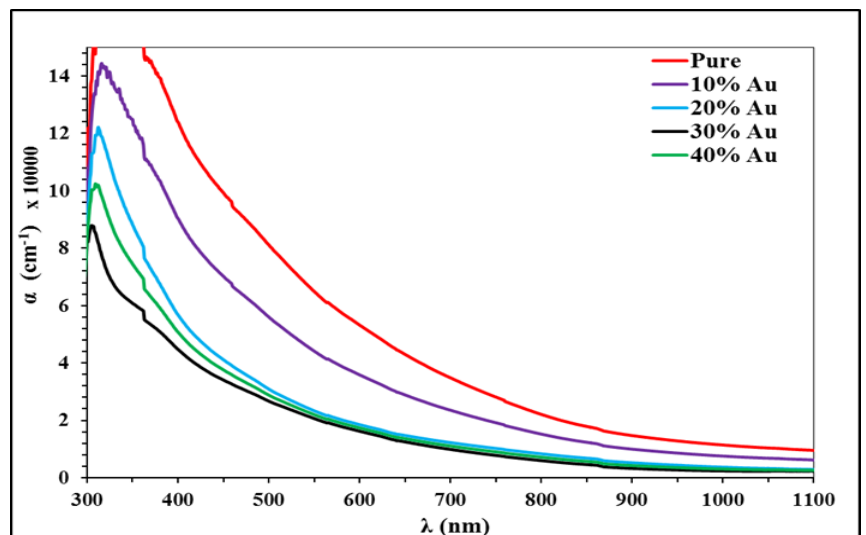
Fig.7: The absorption coefficient for pure WO a function of wavelength.